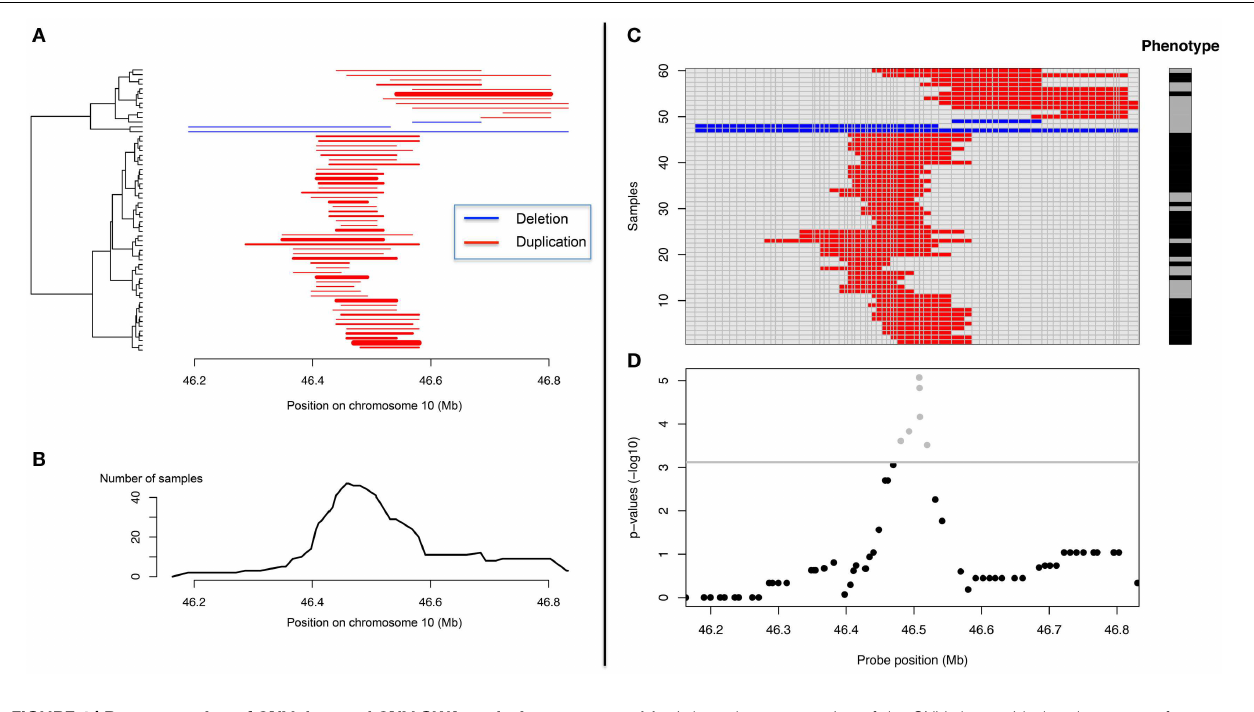
FIGURE 4 | Representation of CNV data and CNV-GWA analysis . (A) CNV representation on chromosome 10 ( X axis) for different subjects ( Y axis). (B) Frequency representation of the same CNV.